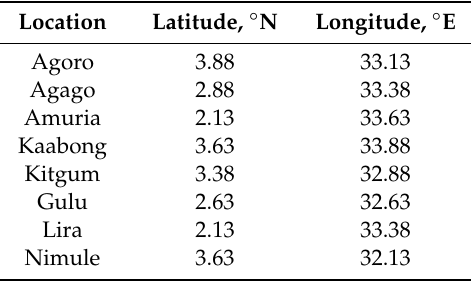
Table 1. TRMM rainfall data location